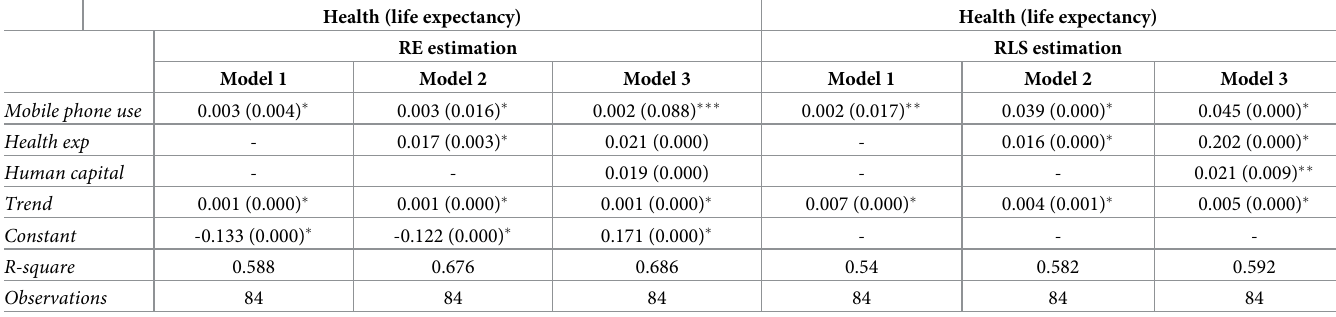
Table 4. Results of ICT and health (life